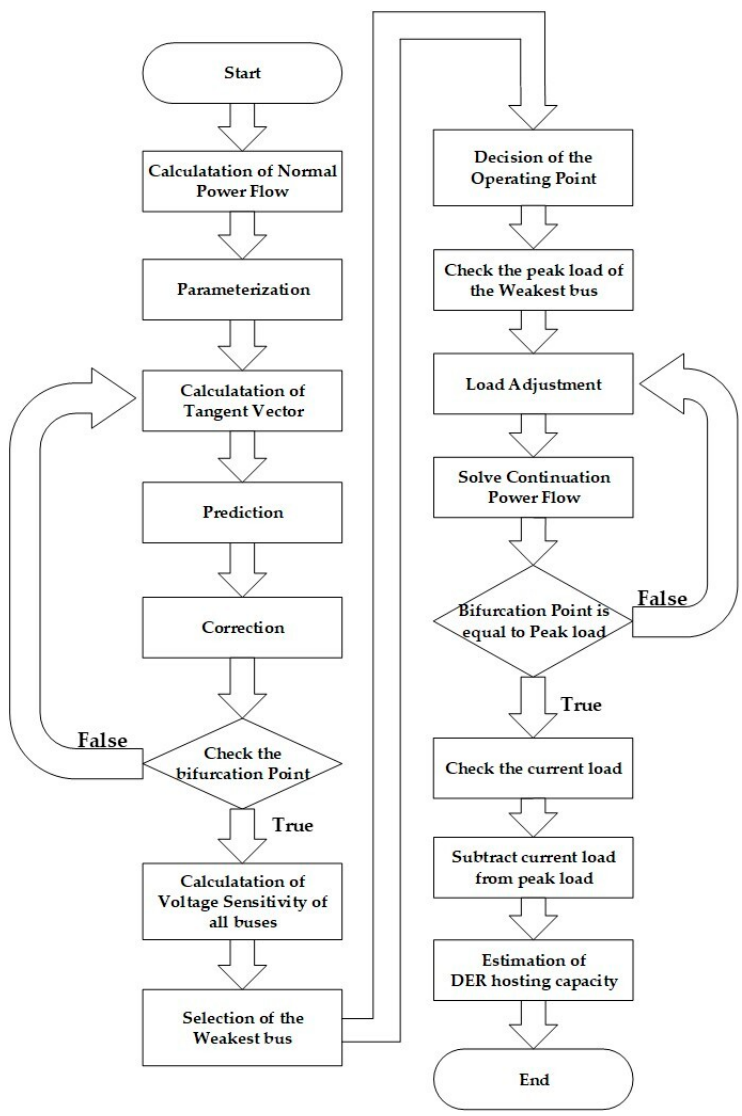
Figure 3. Algorithm for estimating the distributed energy resource (DER) hosting capacity.